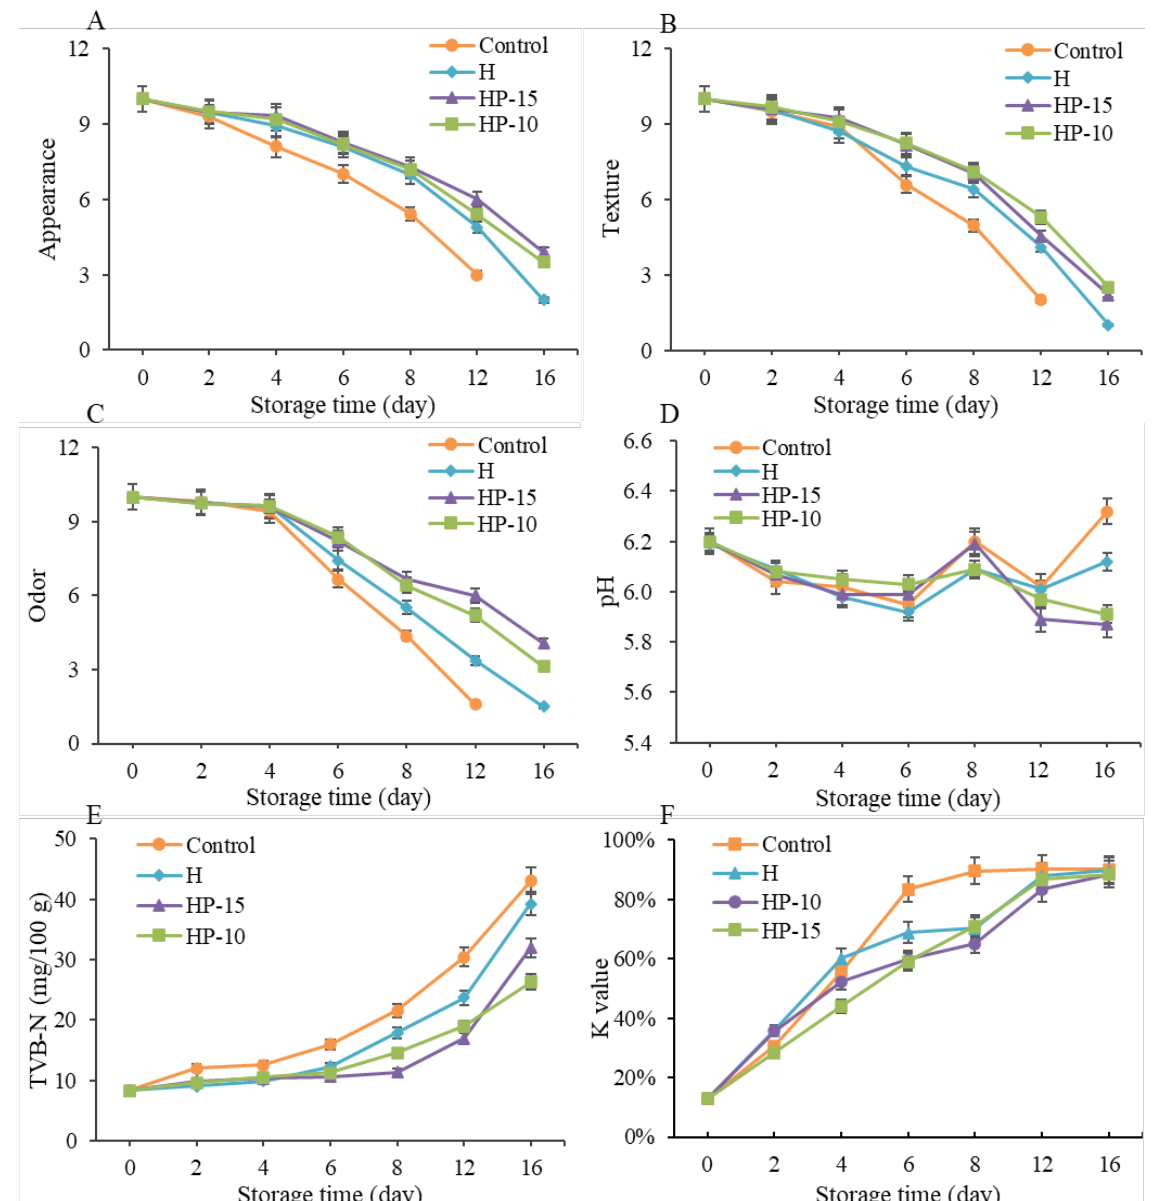
Figure 5. Changes in quality and biochemistry of sturgeon fillets during refrigerated storage. ( A ) Appearance, ( B ) texture, ( C ) odor, ( D ) pH value, ( E ) total volatile basic nitrogen (TVB-N), and ( F ) K-value (CK: control; H: 2% sodium alginate + antibacterial agents; HP-10: 2% sodium alginate + antibacterial agents + 1:10 protein solution; HP-15: 2% sodium alginate + antibacterial agents + 1:15 protein